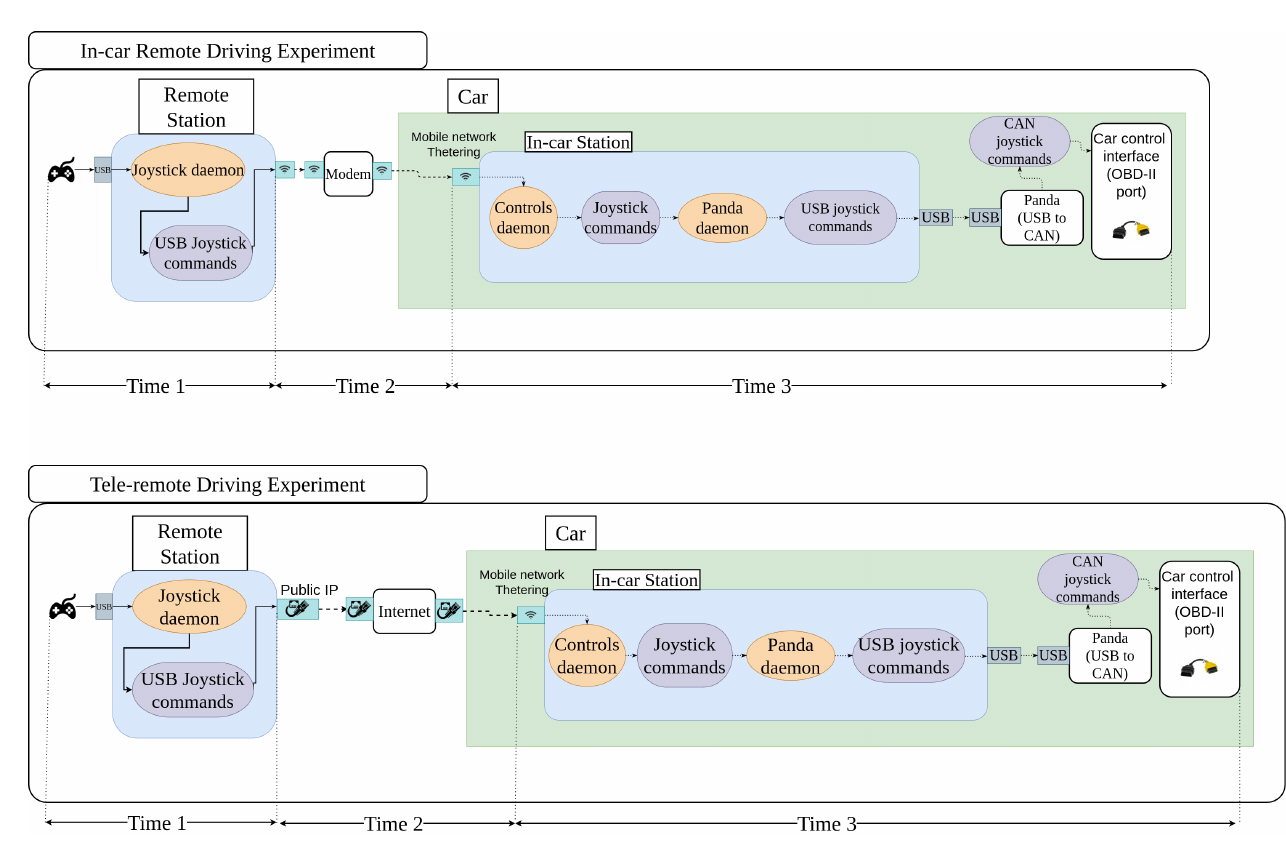
Figure 4. Graphical representation of In-car Remote Driving Experiment ( top ) and Teleremote Driving Experiment ( bottom